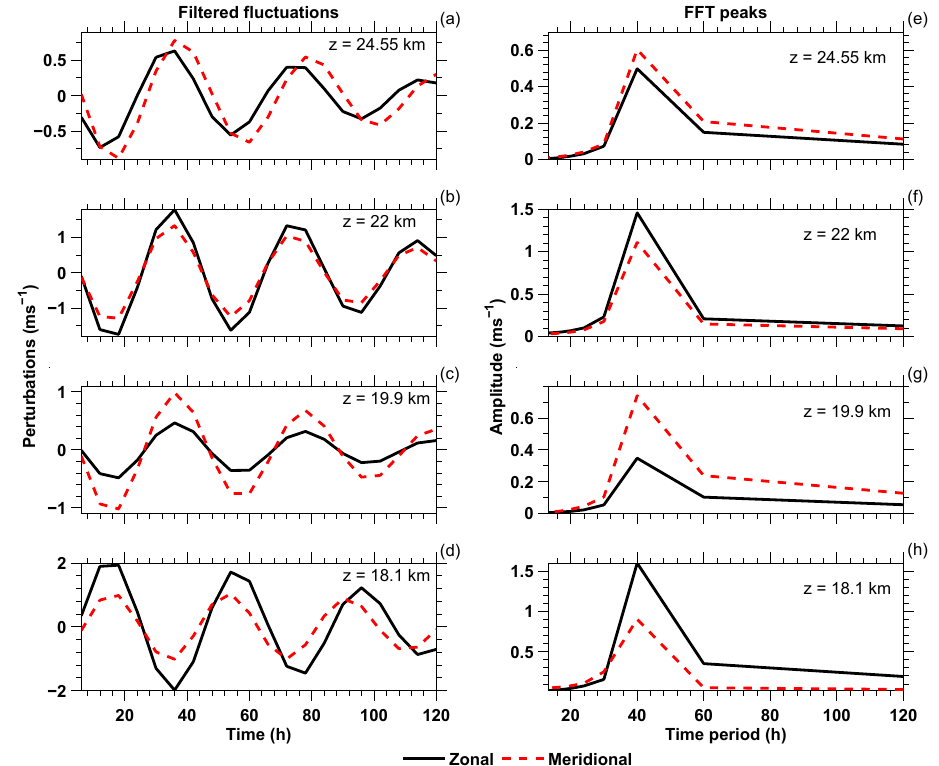
Figure 1. Time series of filtered (Butterworth filter) fluctuations (ms − 1 ) of zonal and meridional winds (a–d) and corresponding FFT spectra (e–f) at a few